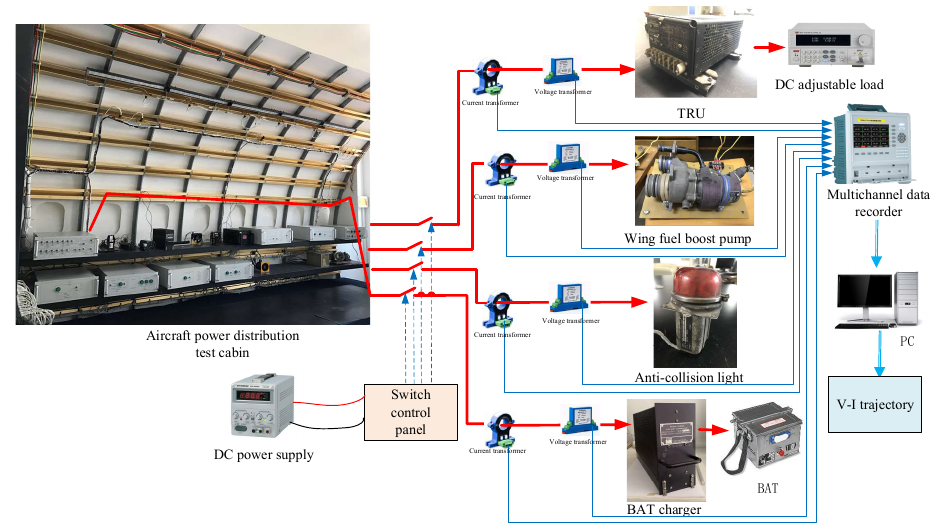
Figure 3. Schematic of the experimental platform in a large test-aircraft cabin.